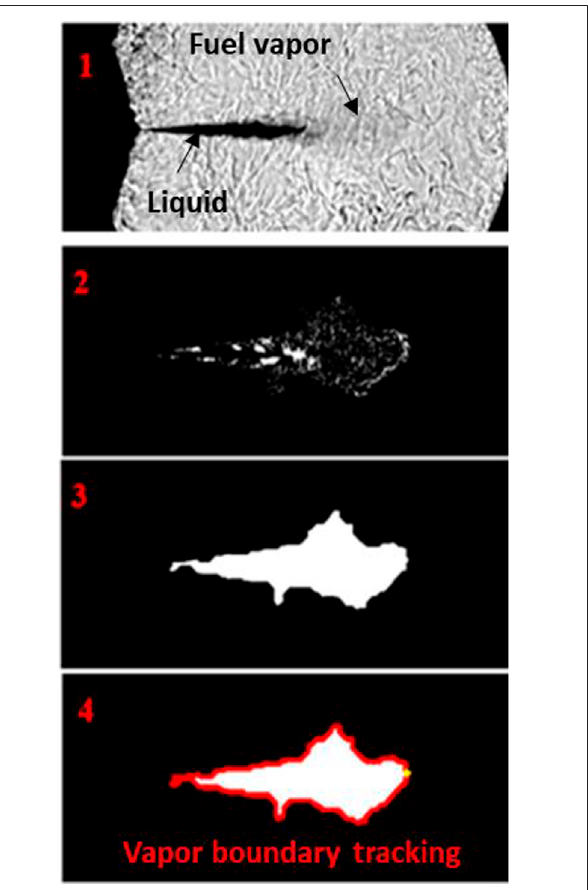
FIGURE 6 | Vaporizing shadowgraph image processing methodology (Zhang et al.,